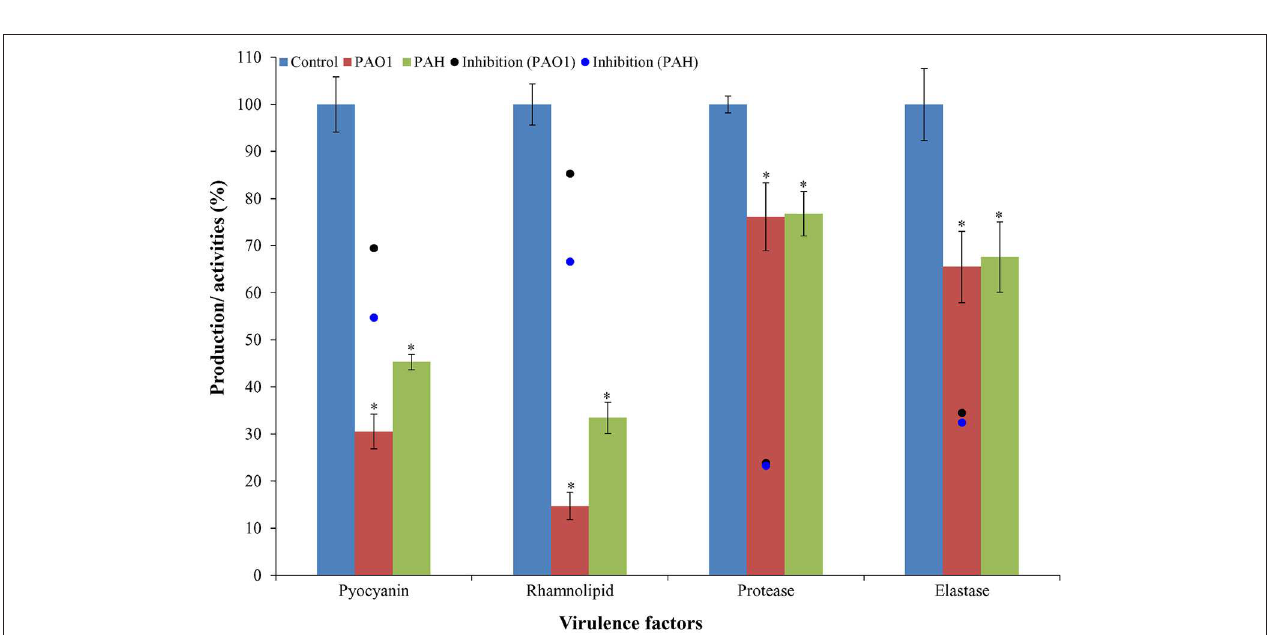
FIGURE 8 | Effect of D. tsuruhatensis SJ01 extract on the virulence factors of P. aeruginosa . The effect of bacterial extracts (SJ01; 0.1 mg/ml) was studied on the production of virulence factors of reference P. aeruginosa strains by quantifying pyocyanin and rhamnolipid, and analyzing elastase and protease activities. *Indicates significant differences from the control at P < 0.05